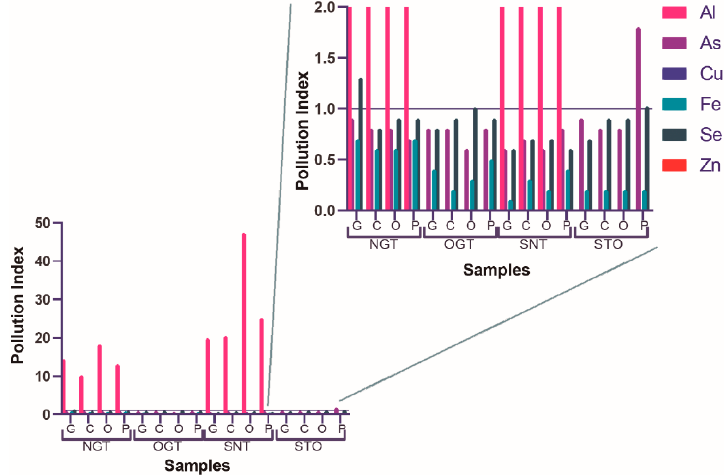
Figure 2. Pollution Index (PI) of the trace elements quantified in tuna fish.